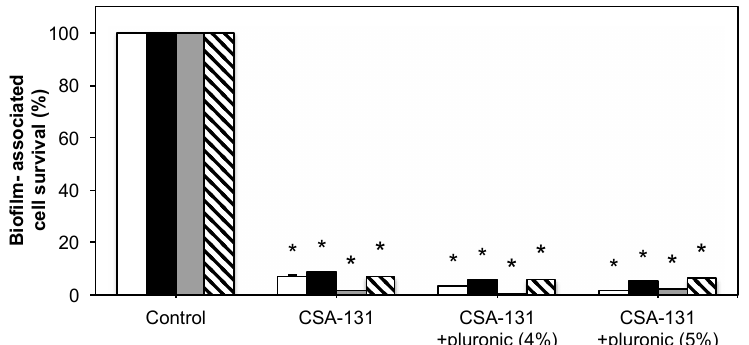
Molecules 2018 , 23 , x 7 of 11 Figure 3. Antibiofilm results determined through colorimetric (XTT) assay represented as percent survival. White bars: S. aureus (ATCC 25923); black bars: P. aeruginosa (ATCC 47085); gray bars: C. albicans (ATCC 90028); hashed bars: C. auris (CDC 384). * indicates p < 0.05 relative to controls.